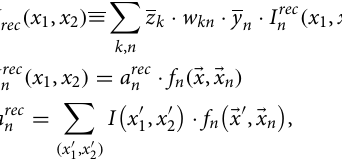
−→ x = ( x 1 , x 2 ) is a point in the image, f n ( · ) is the Difference-of-Gaussian filter in Eq. (5) with its center where −→ x n = ( x n 1 , x n 2 ) . w kn is the modified feedforward weight. z k , y as n are averaged spiking rates of corresponding neurons over timesteps and simulations. I the reconstructed gray-scale value of ( x 1 , x 2 ) . The reconstruction in Eq. (12) performs as averaged brightness perception. Reconstructions of two images are normalized before comparison. Reconstructed gray-scale values of all the points in two images are collected together into a set. The mean value and standard deviation of this set are common parameters for normalizations. In this way, perception of the same target upon different contexts can be simulated and compared. For the first set, the target in Sti. 1 appears to be lighter (Fig. 2B). For the second set, the target in Sti. 4 appears to be lighter (Fig. 2G). Simulated brightness perception has the relationship as same as that in experiments 65 . The contextual modulation index (CMI) and the cross-correlation are used to qualify contextual modifications of excitatory neural responses and excitatory neural lateral interactions, respectively. For instance, the CMI of the k th second-layer excitatory neuron to Sti. 1 and Sti. 2 is calculated as 37 :